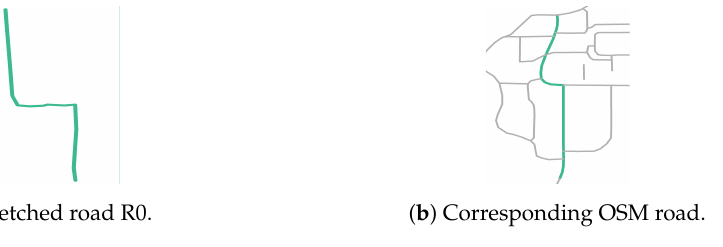
Figure 3. A road from a sketch and the corresponding road from OSM.